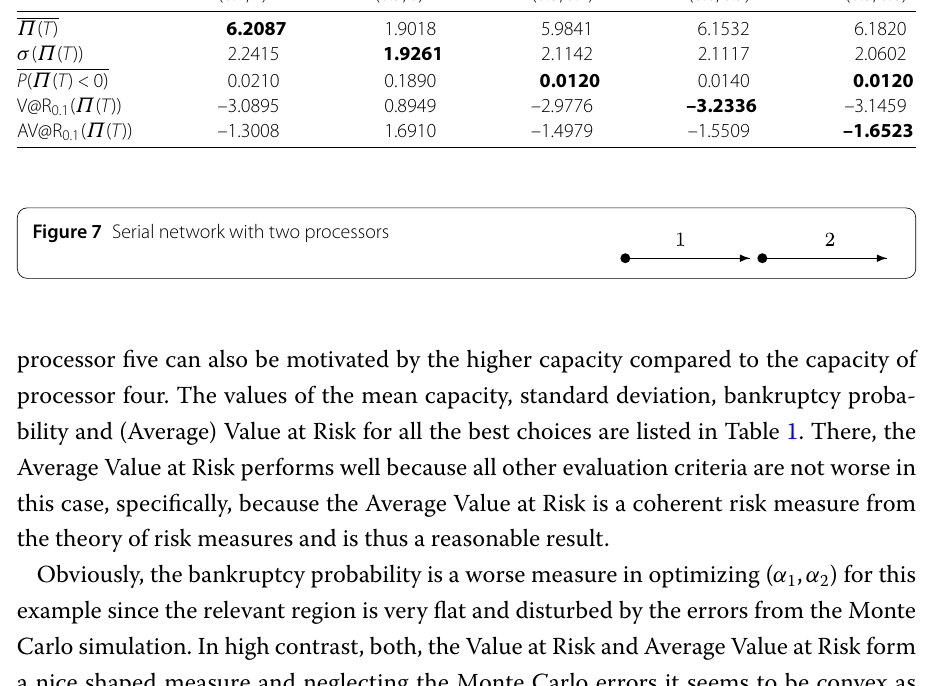
Table 1 Comparison of the different profit evaluations (0.4,1) (0.9,0) (0.5,0.7) (0.6,0.9) (0.5,0.8) Π ( T )